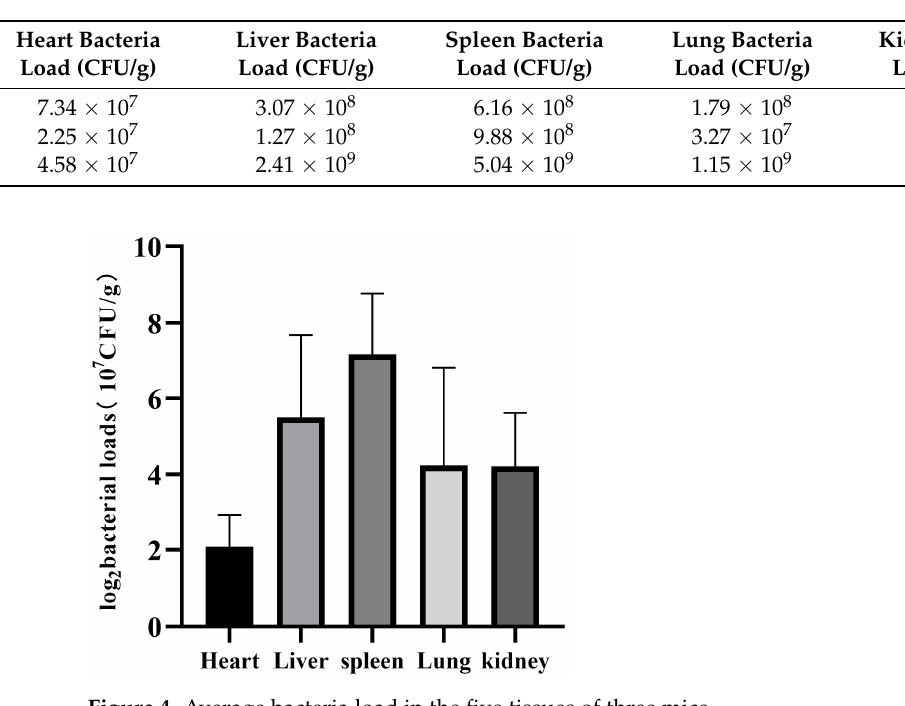
Figure 4. Average bacteria load in the five tissues of three mice.